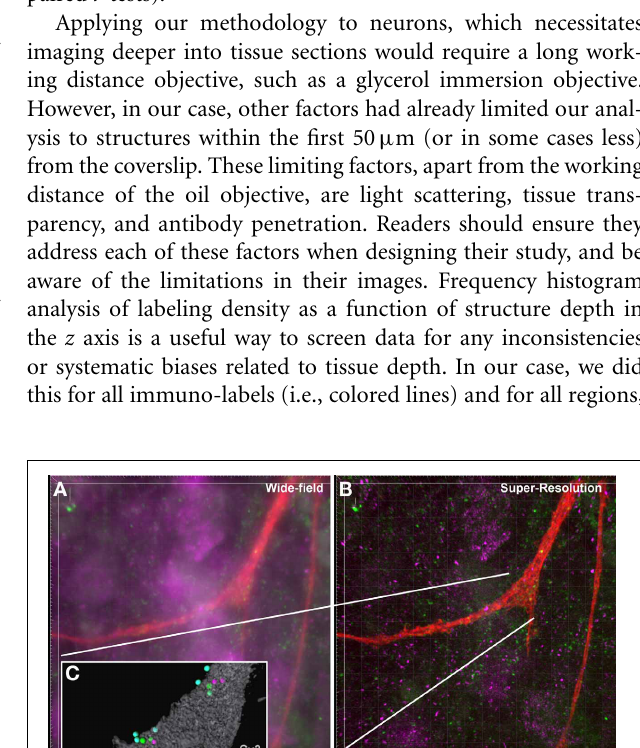
confocal microscopy. (A) shows a maximum intensity projection of a wide-field z -stack imaging Neurobiotin-filled hypoglossal motor neuron distal dendrites (red) with glutamatergic VGLUT2 (green) and PSD-95 (purple). (B) shows a maximum intensity projection of a super-resolution z -stack imaging of same distal dendrites (red) with glutamatergic synapse labeling with VGLUT2 (green) and PSD-95 (purple). Inset (C) shows the Imaris method when applied to the super-resolution sample, with the neuronal surface (gray), co-localized to within 1 μ m of each other VGLUT2 (green) and PSD-95 (purple). VGLUT2 spots that are within 1 μ m of the neuronal surface are colored blue. Scale bars: (A,B) 10 μ m and (C) 5 μ m.